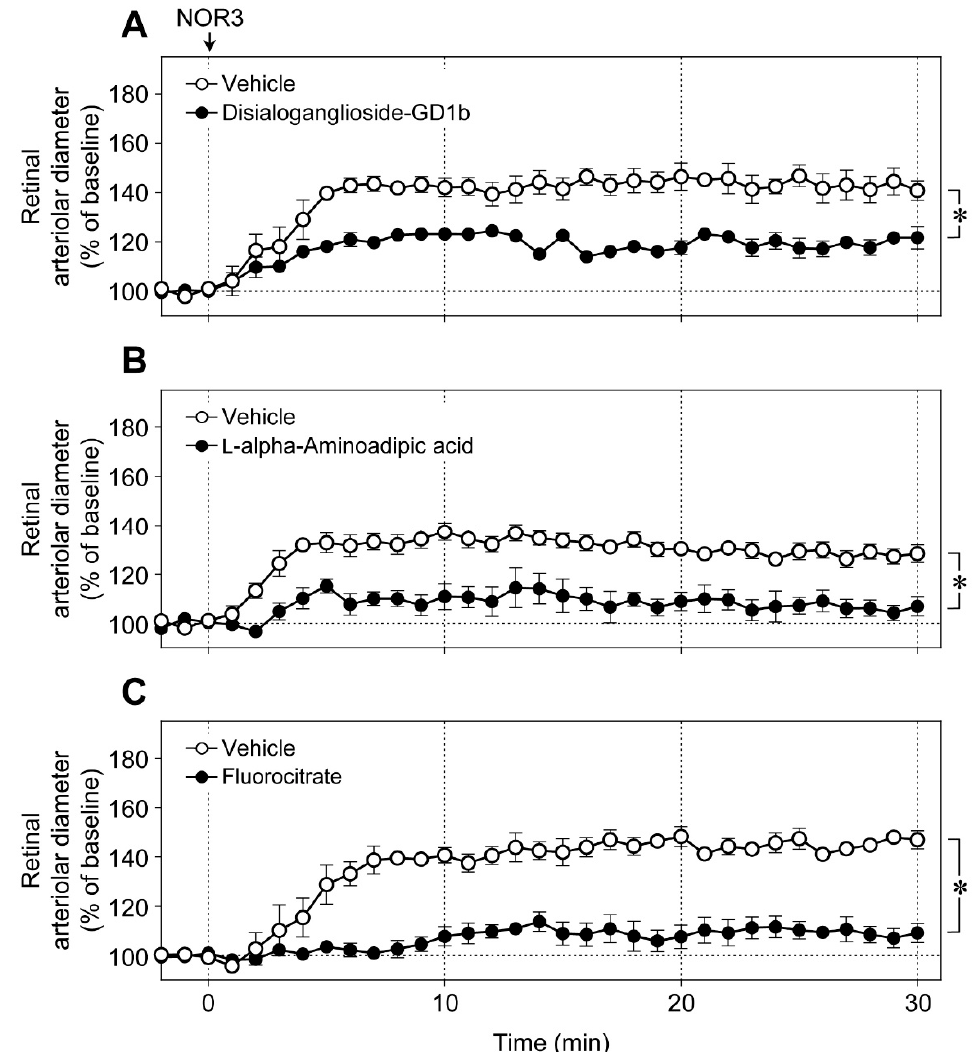
Figure 6. Effects of glial toxins on the retinal vasodilation induced by intravitreal injection of NOR3. NOR3 (5 nmol)-induced changes in retinal arteriolar diameter in ( A ) the presence of disialoganglioside-GD1b (15 nmol), ( B ) l -alpha-aminoadipic acid (250 nmol), ( C ) fluorocitrate (450 pmol) or the vehicle. Each point with a vertical bar represents the mean ± SE from three to seven animals. * p < 0.05.